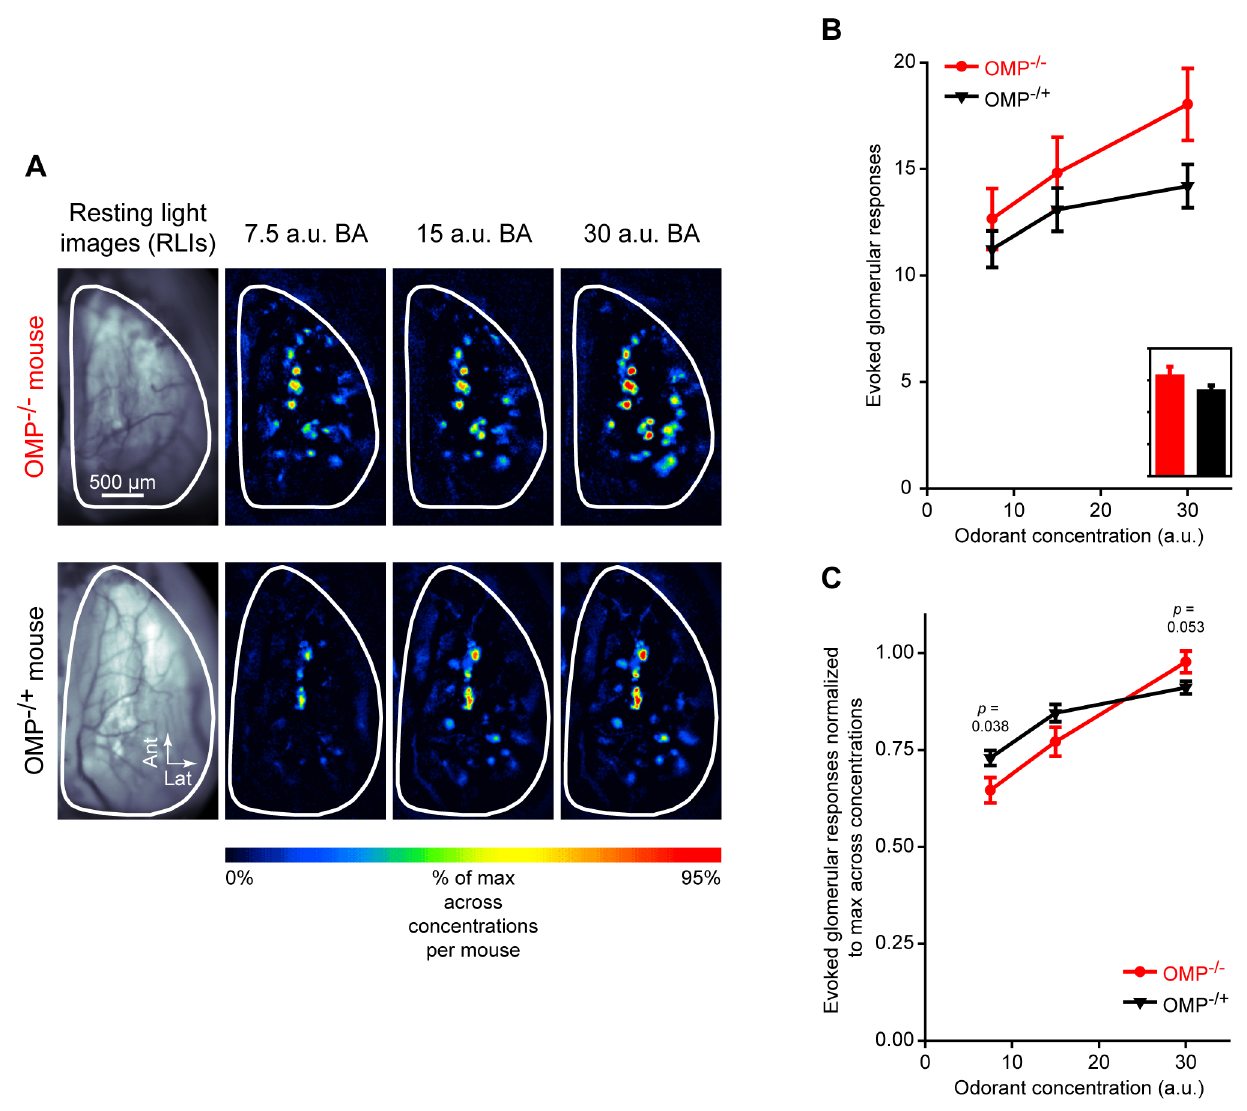
Figure 1. The number of glomeruli receiving odorant-evoked OSN input is enhanced in OMP 2 / 2 mice. ( A ) Resting light images (RLIs) of the dorsal surface of the olfactory bulb through the cranial window ( first column ) and pseudocolored response maps evoked by 3 concentrations of butyl acetate (BA) ( second-fourth columns ). The top row is an example from an OMP 2 / 2 mouse and the bottom row is an example from an OMP 2 / + mouse. ( B ) Mean ( 6 SEM) number of evoked glomerular responses plotted as a function of odorant concentration. The overall group means shown in the inset , which is scaled to the y -axis of B , are averaged across all odors and concentrations. ( C ) Mean ( 6 SEM) number of glomerular responses normalized to the maximum number of evoked responses across 3 odorant concentrations. In B and C OMP 2 / 2 mice and OMP 2 / + mice are shown in red and black , respectively.